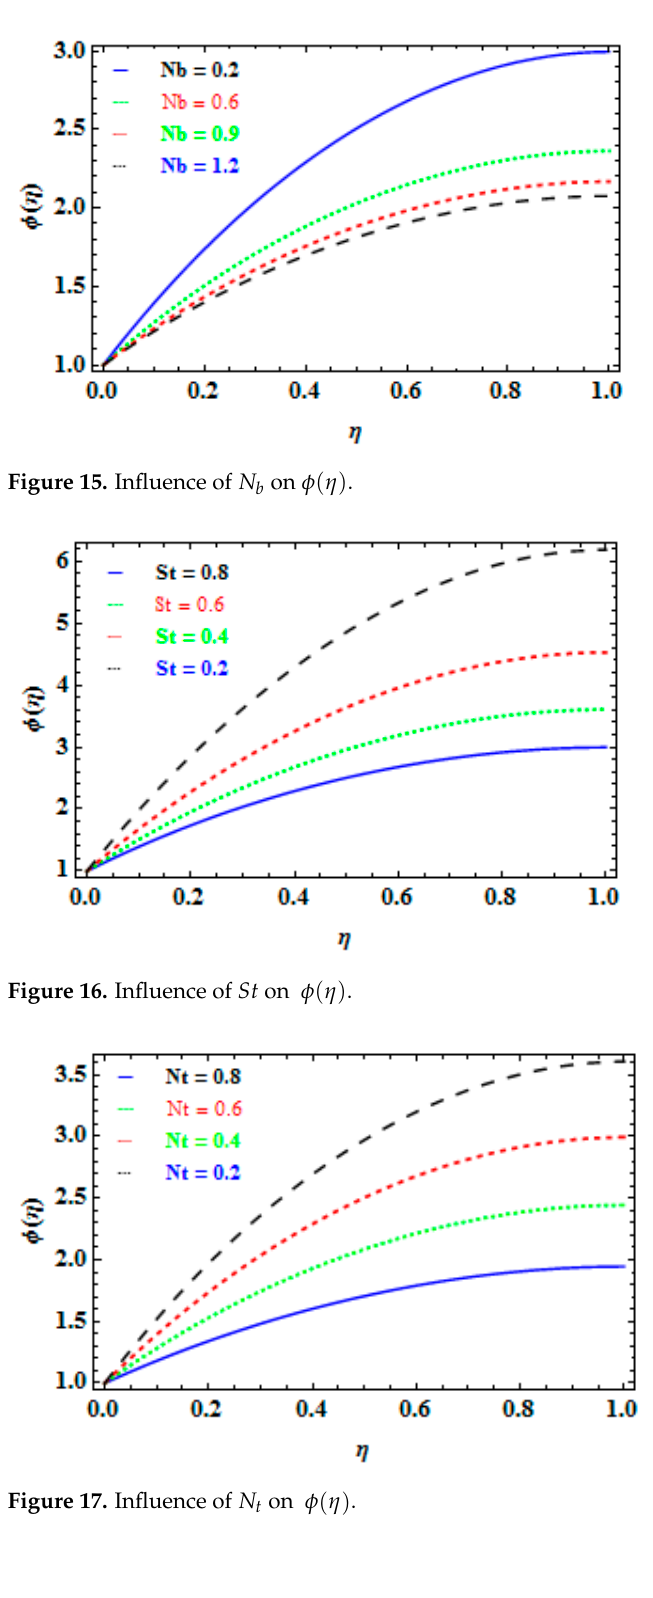
Figure 14. Influence of